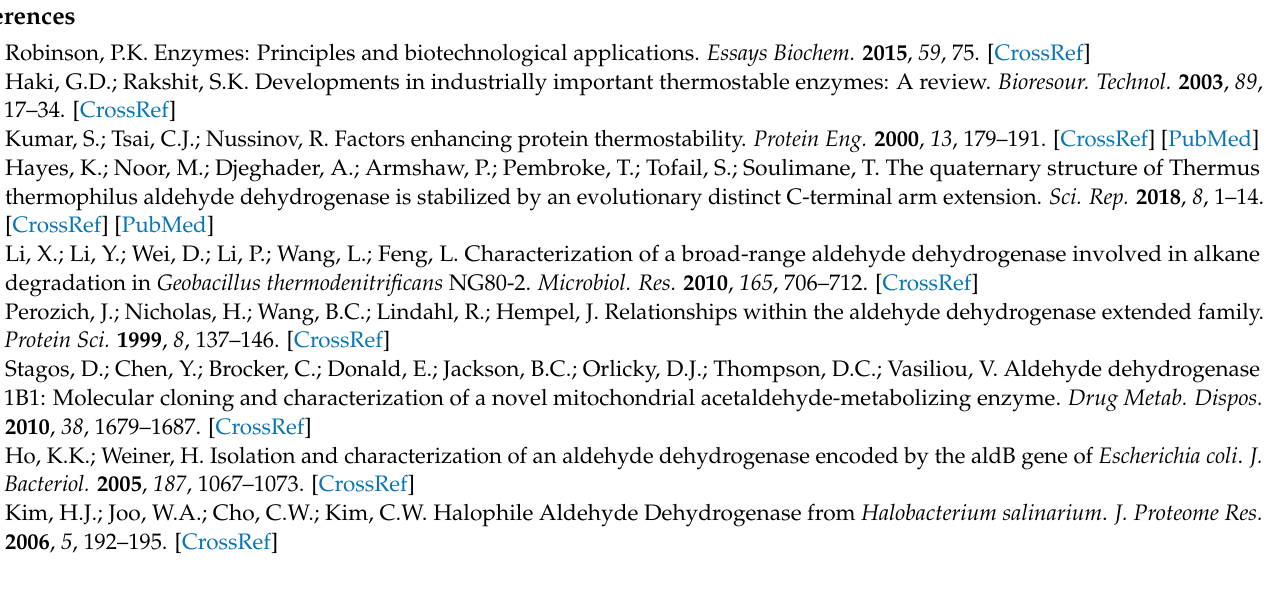
nase; Figure S5: Homology modelling of ALDH by using the SWISS MODEL; Figure S6: Homology modelling of ALDH by using the RaptorX; Figure S7: Chromatogram profile of the purified